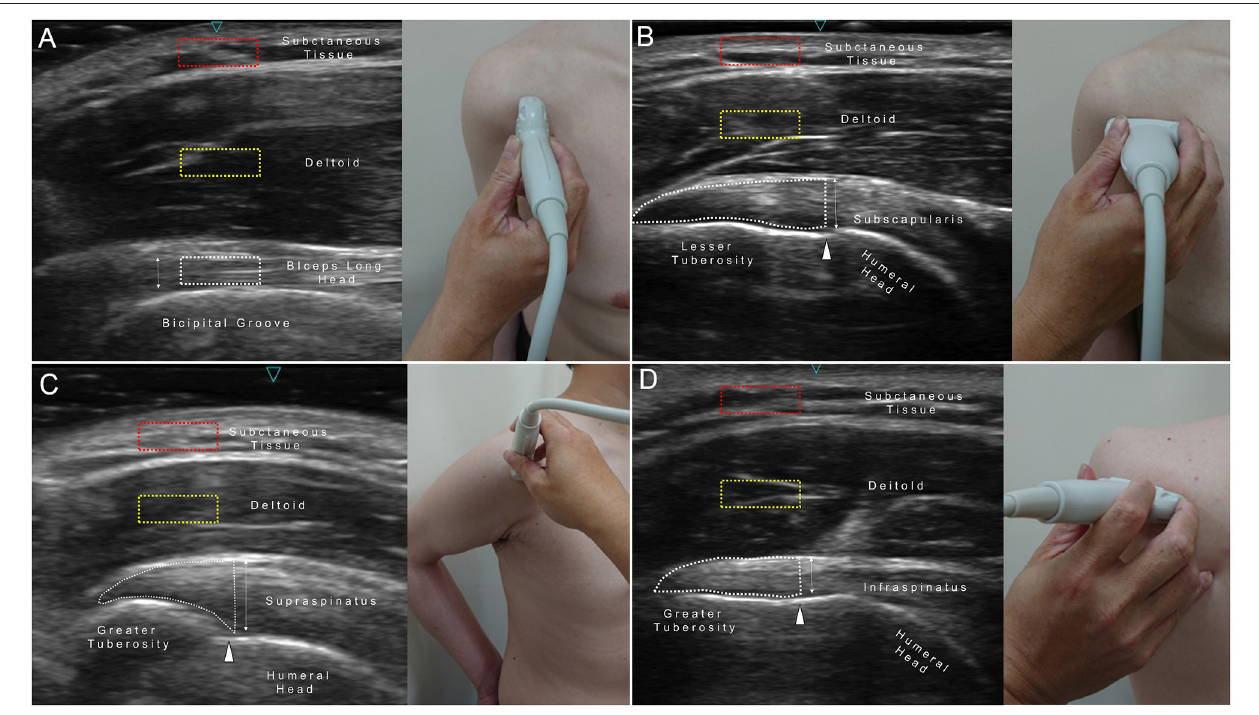
FIGURE 1 | Region of interest (ROI) and site for measuring the echogenicity and thickness of the biceps long head (A) , subscapularis (B) , supraspinatus (C) , and infraspinatus tendons (D) . Red dashed squares, ROI for the subcutaneous tissue; yellow dashed squares, ROI for the deltoid muscle; white dashed area, ROI for the target tendon; double arrowed line, tendon thickness; white arrowheads, anatomic neck of the